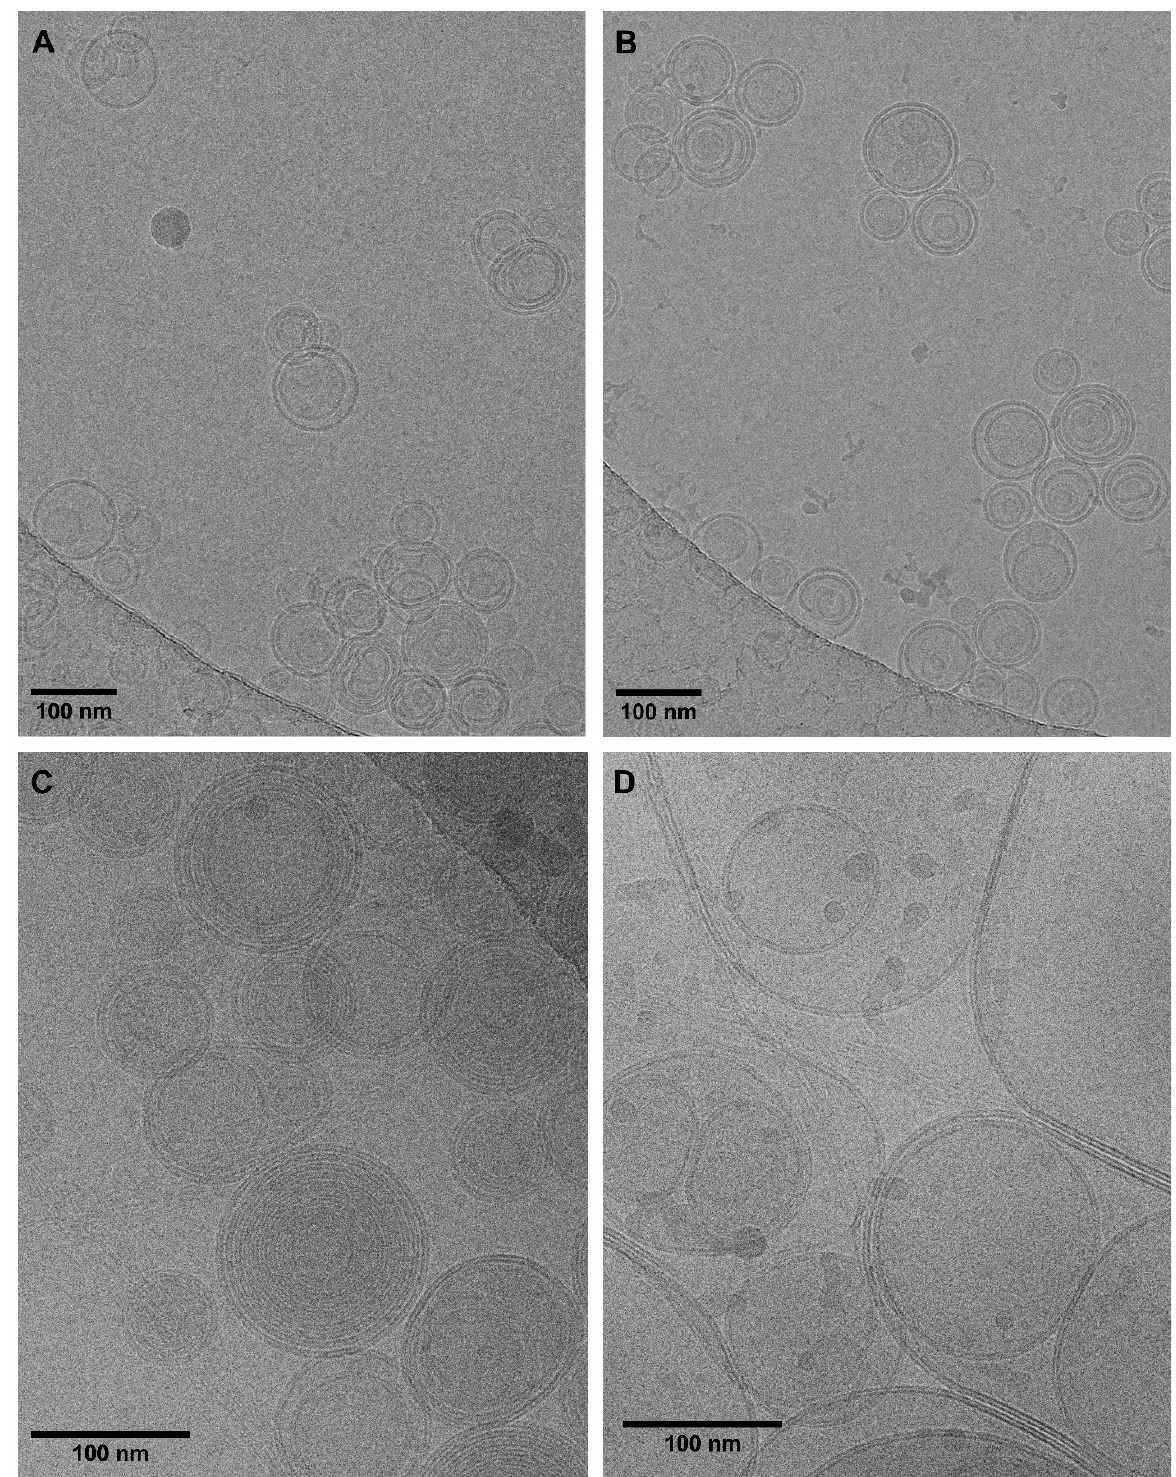
Figure 4. Visualization of the vesicles embedded in the HPMC gel before freeze-drying ( A ) and after redispersion of the freeze-dried product ( B ) using Cryo-TEM. The micrographs of the liposomal collagen–hyaluronic acid gel before freeze-drying and after redispersion of the lyophilized cake are presented in ( C , D ), respectively.